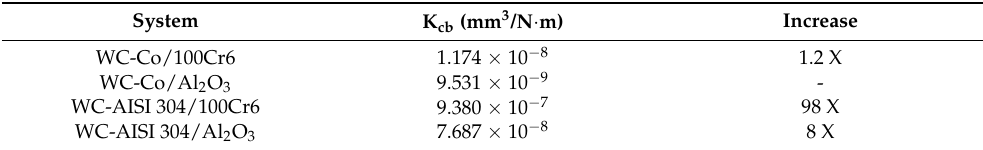
Table 7. Wear coefficients of the counter bodies for the systems: WC-Co/100Cr6, WC-Co/Al 2 O 3 , WC-AISI 304/100Cr6 and WC-AISI 304/Al 2 O 3 and corresponding increased number of times in relation to the wear coefficient of system WC-Co/Al 2 O 3 . System K cb (mm 3 /N · m) Increase